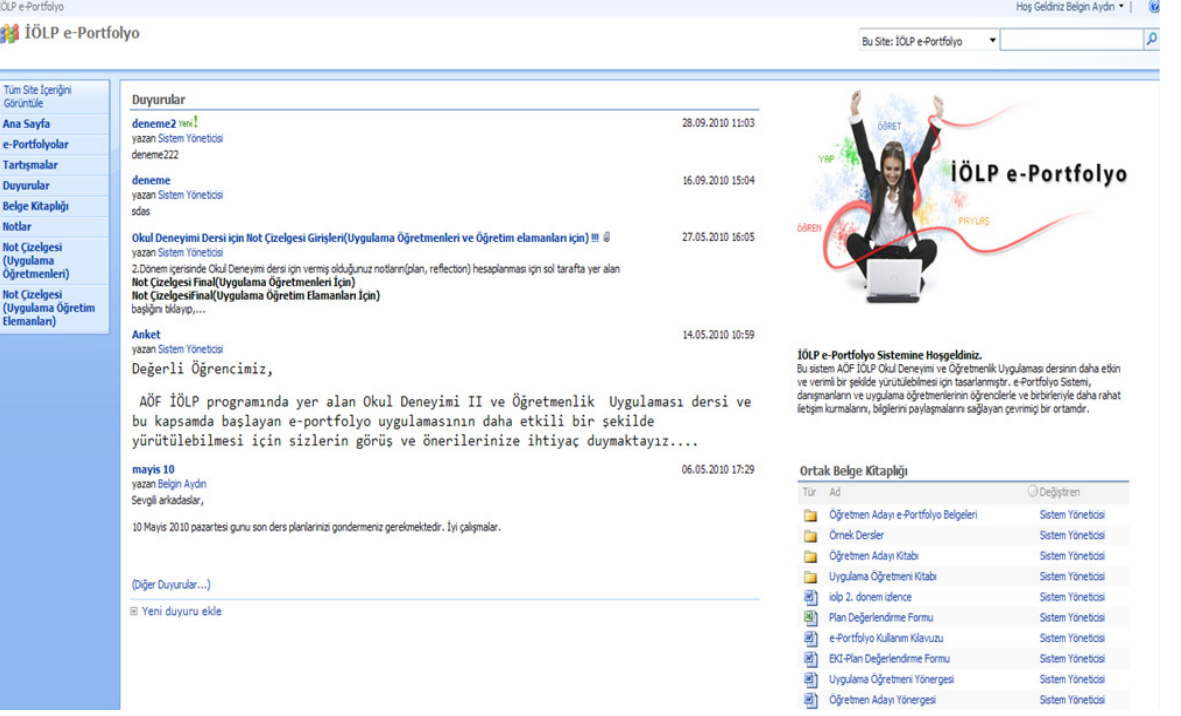
Figure 1. Home page of e-portfolio application used in the DELT